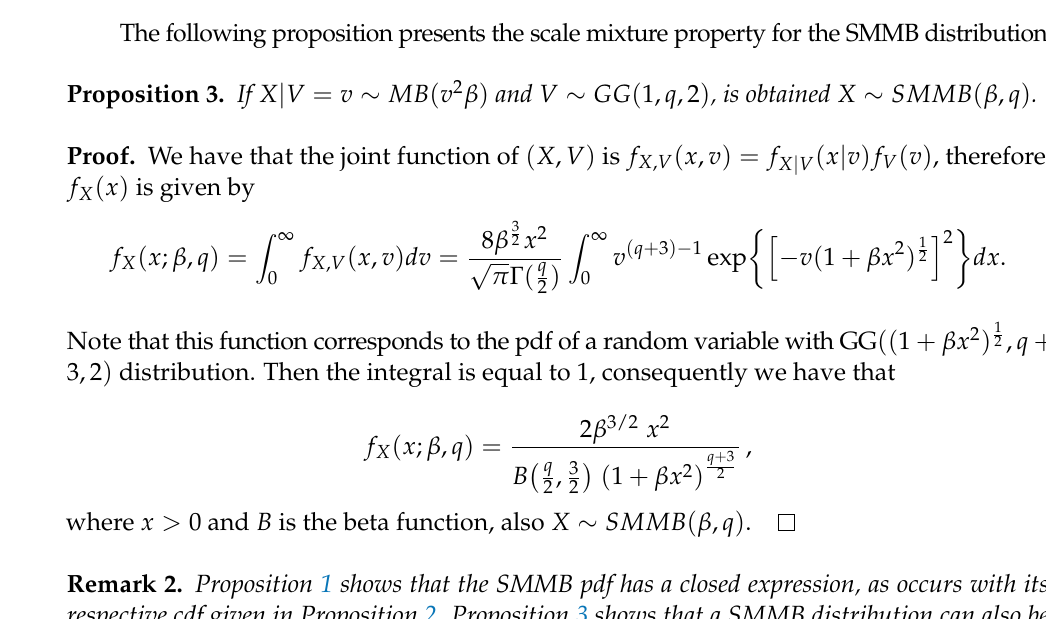
Figure 3. fq ( x ) function graphs for different values of q